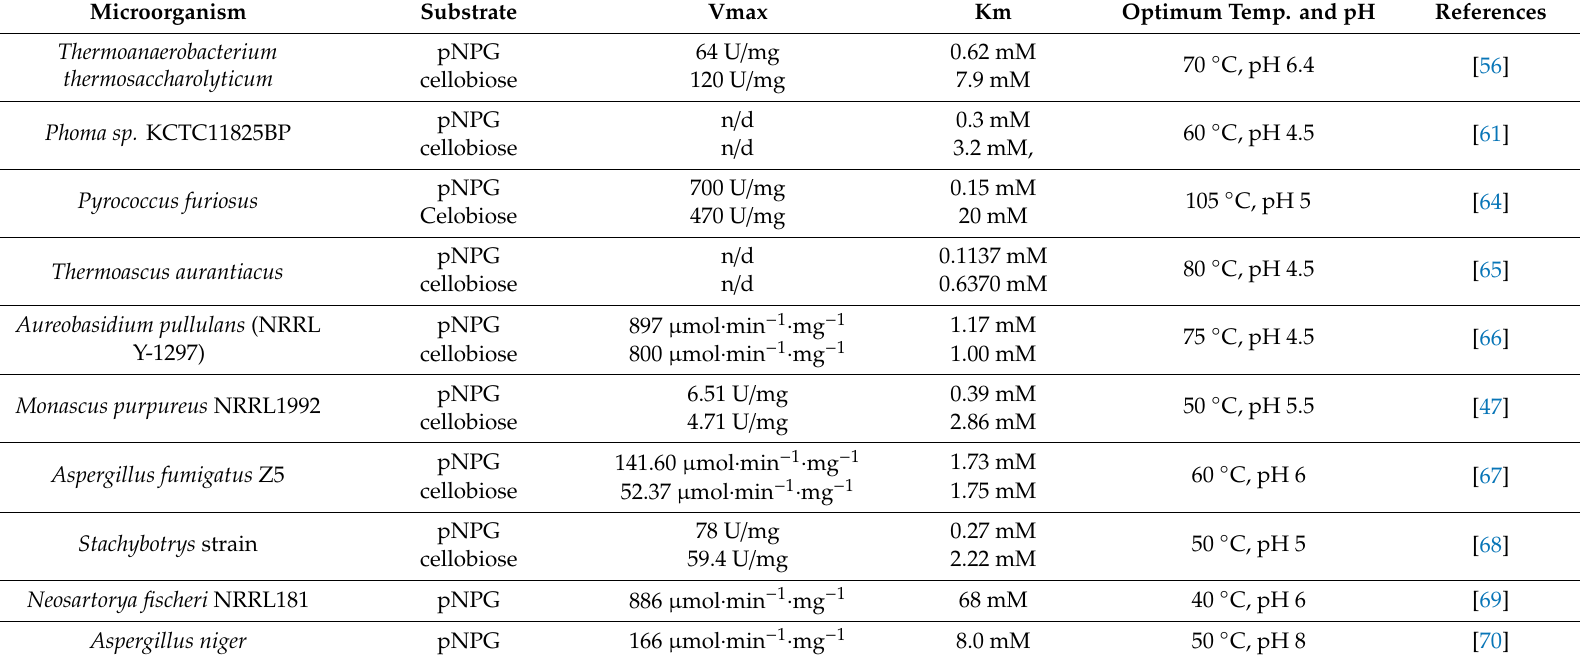
Table 13. Kinetic parameters for β -glucosidases from various sources towards p NPG and cellobiose; n / d is not